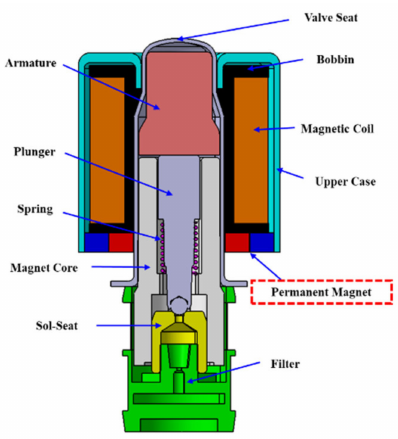
Figure 6. Schematic of the permanent magnet